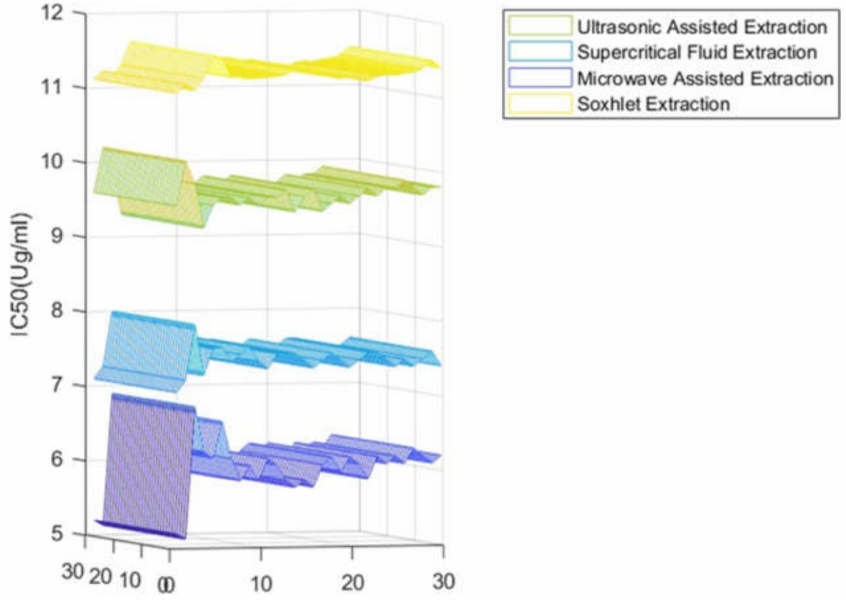
Figure 4. Antioxidant activity of carob pod extracts using different extraction